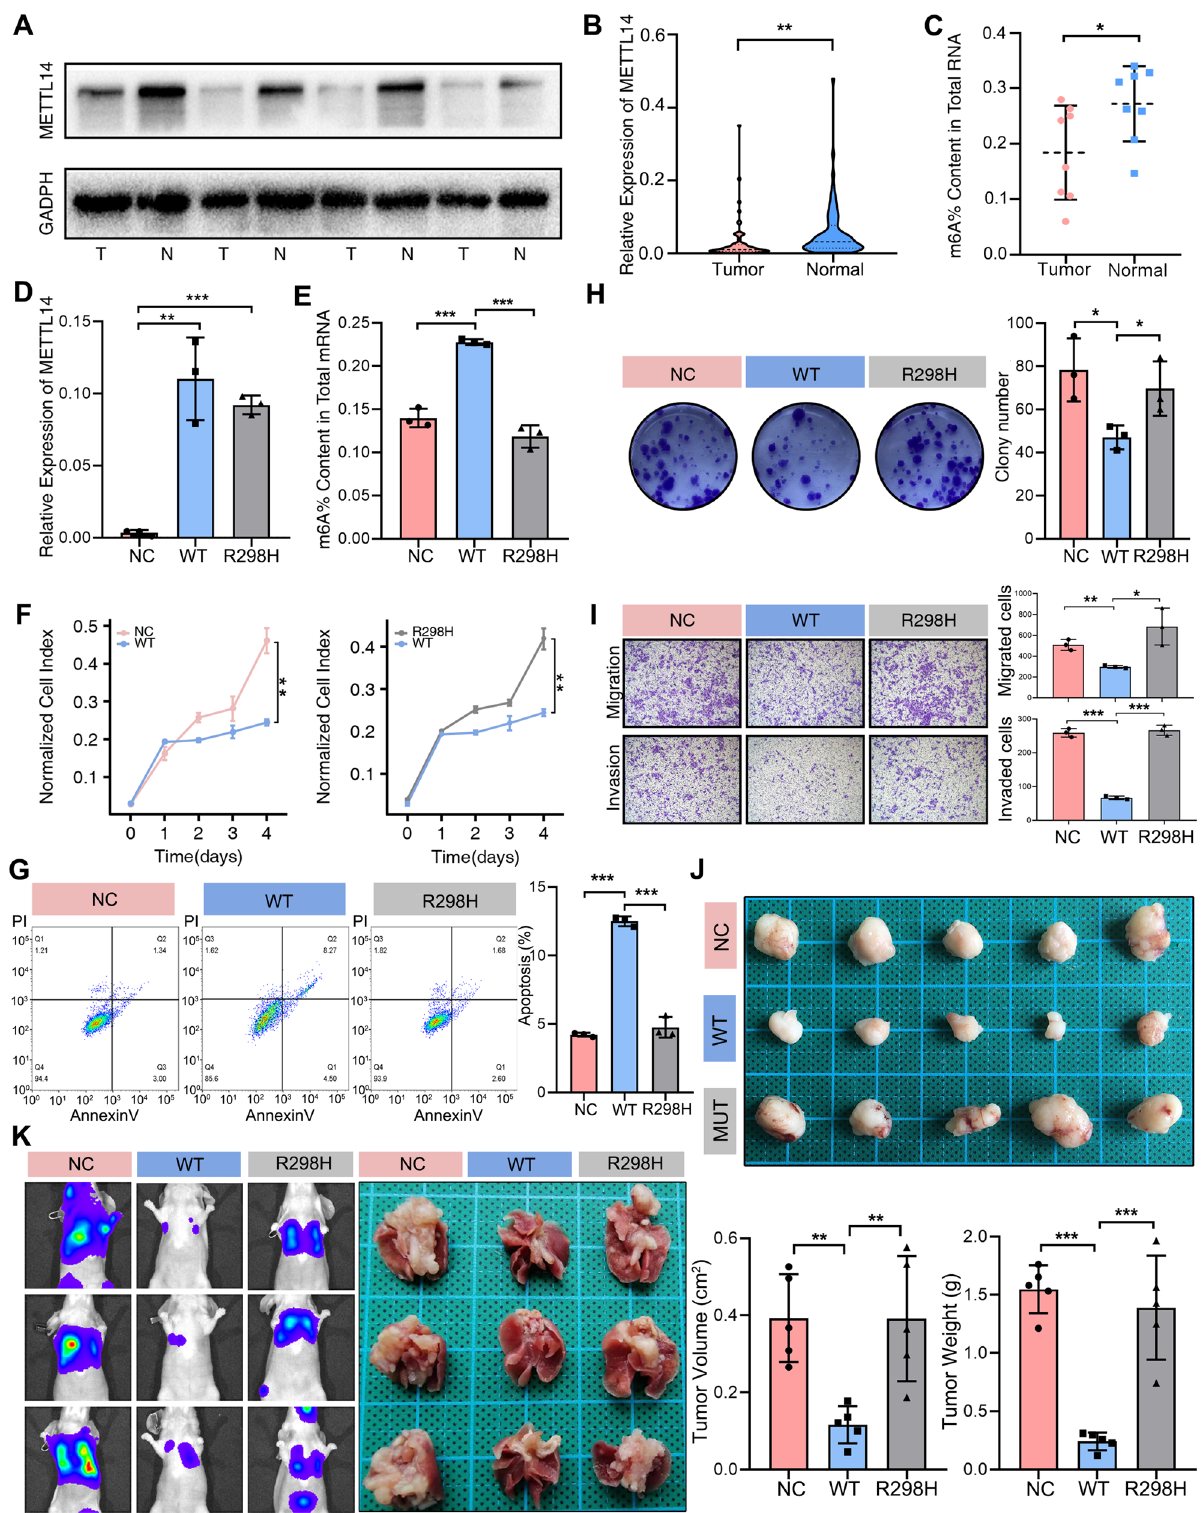
suppressed tumor growth as re fl ected by the signi fi cant reduction of tumor size and weight in nude mice, and in a lung metastasis model, METTL14 wt could also restrain pulmonary metastasis signi fi cantly. Consistent with results from in vitro experiments, the inhibition of METTL14 R298H on tumor proliferation and lung metastasis was apparently attenuated in vivo when compared to the METTL14 wt group (Fig. 4J, K). Therefore, these data implied